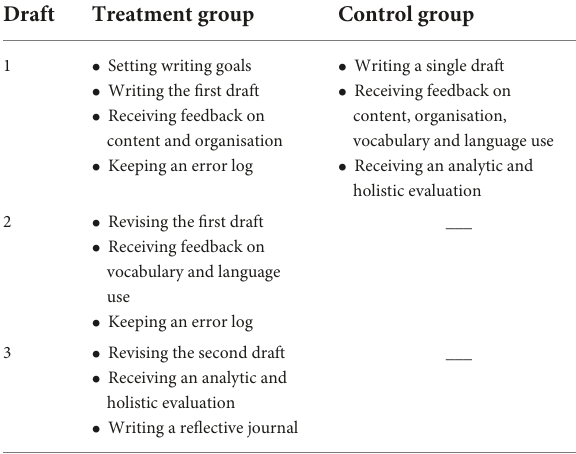
TABLE 3 Feedback loop for the treatment and control